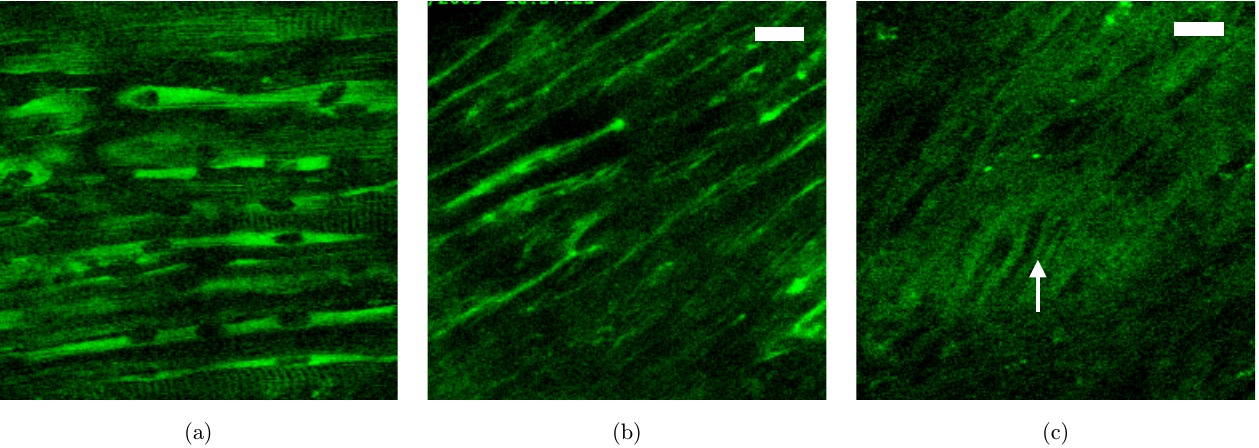
Fig. 5. (a) In vivo muscle cells imaging in mouse ear skin (b) ex vivo smooth muscles cells in normal aorta and (c) ex vivo smooth muscle cells in plaque. (Bar: 20 (cid:4) m in (a), 30 (cid:4) m in (b) and